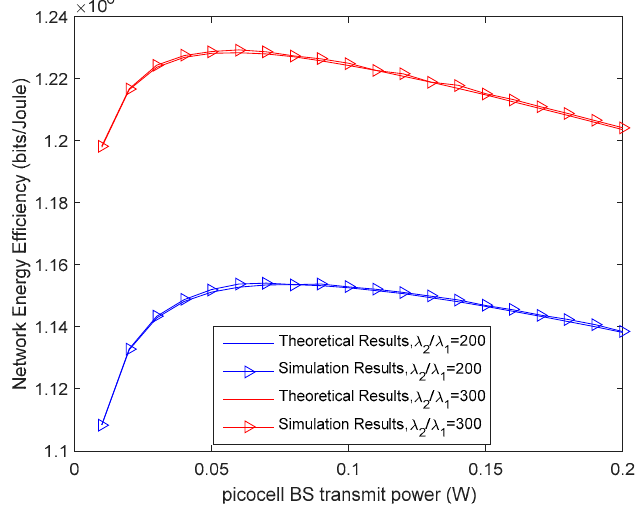
Figure 3. Network EE versus picocell BS transmit power.